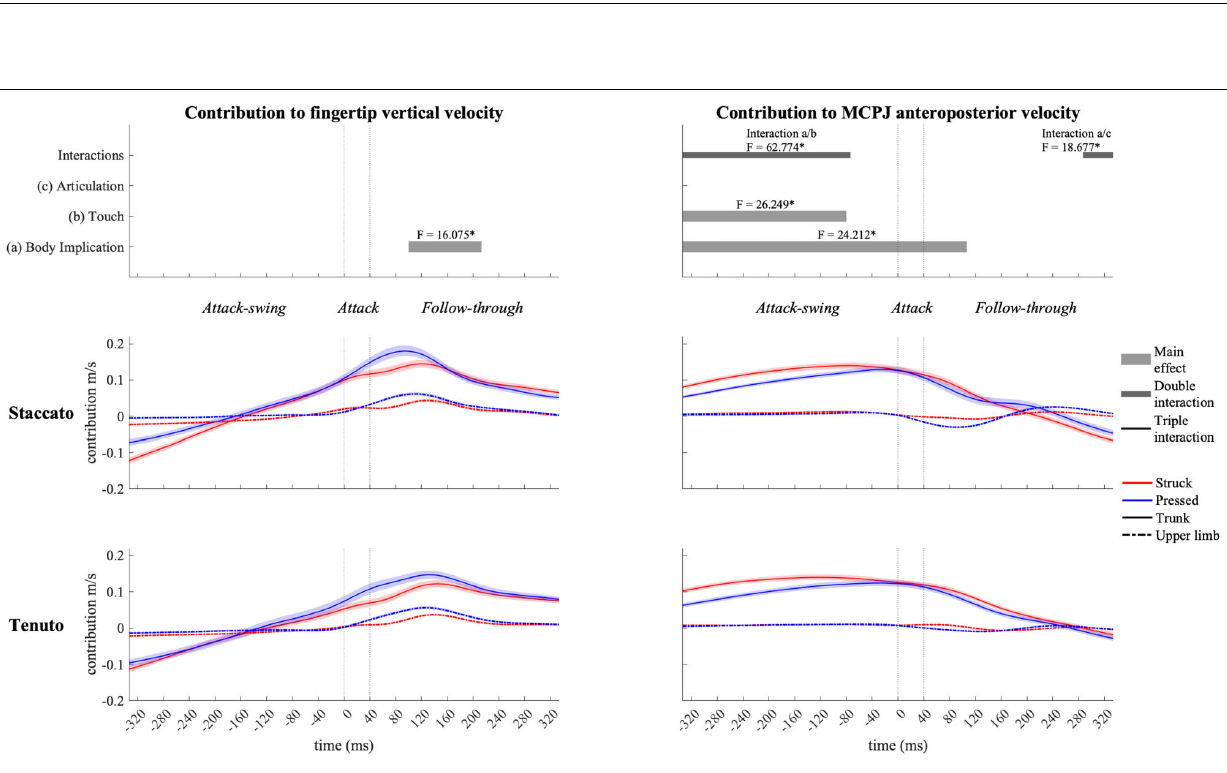
Frontiers in Psychology |